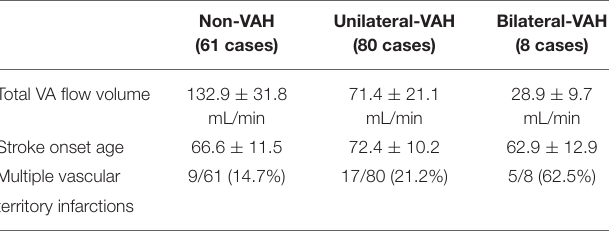
TABLE 2 | Total VA flow volume, onset age and stroke location analysis in bilateral, unilateral, or non-vertebral artery hypoplasia groups.